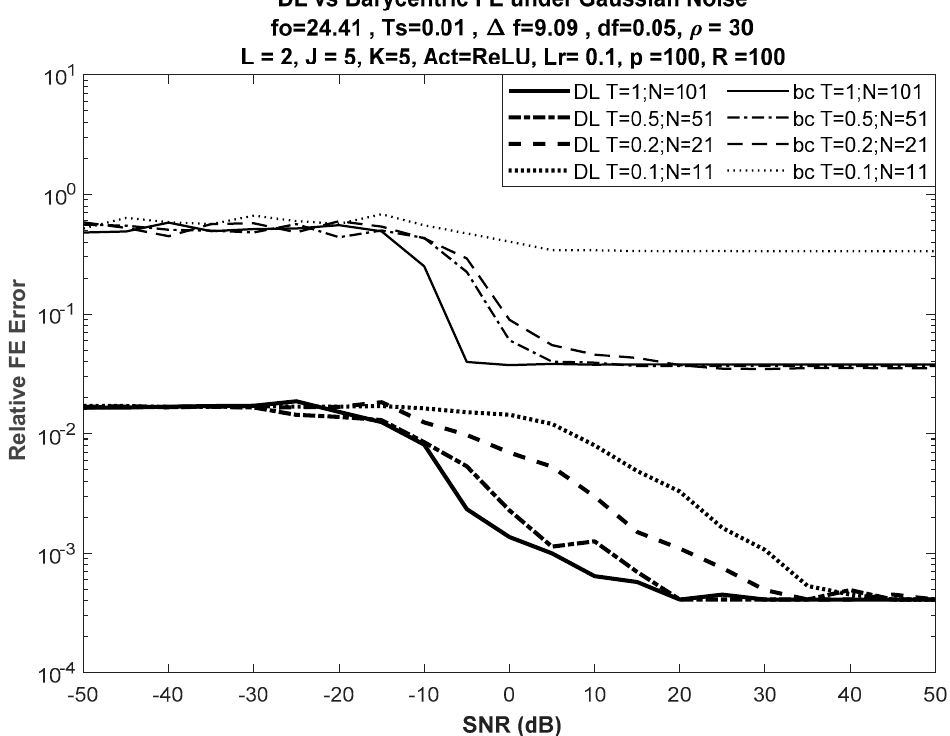
Figure 3. DL vs. barycentric discrete Fourier transform (DFT)-based FE for different input lengths with J = K = 5. Note that DFT-based FE failed when N = 11, while DL-based FE gave reasonable results even at low signal-to-noise ratio (SNR).